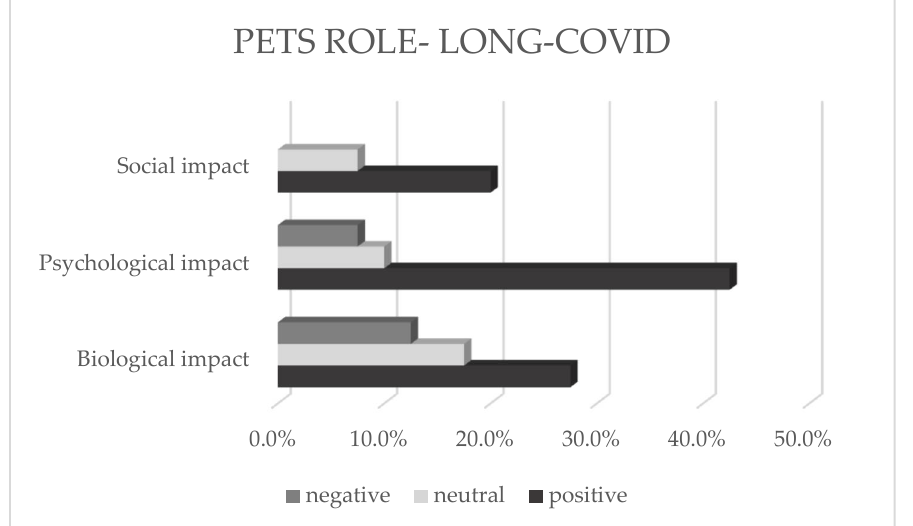
Figure 5. Percentages of the pet’s role within the group “Long-Covid”.